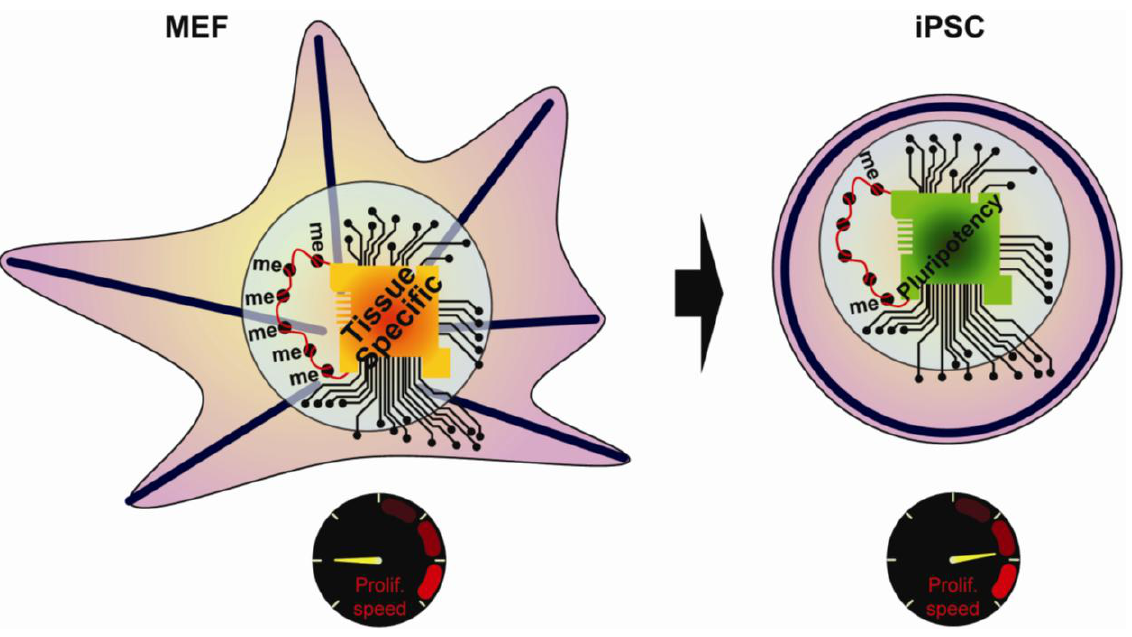
Figure 1. During reprogramming, the MEF have to increase their speed of proliferation, remodel their actin network (blue line), change their transcriptionnal circuitry and reactivate their